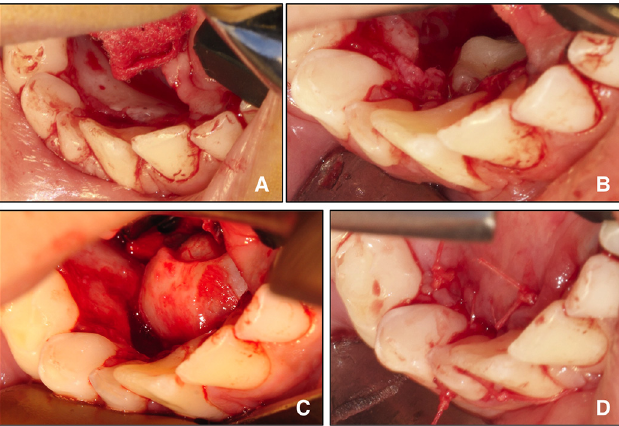
Fig. 4. Extraction of the dilated odontoma (DO). (A) Full-thickness mucoperiosteal lingual fl ap. (B) Osteotomy of the lingual cortical bone. (C) Luxation and extraction of the DO. (D) The wound was closed using absorbable sutures.